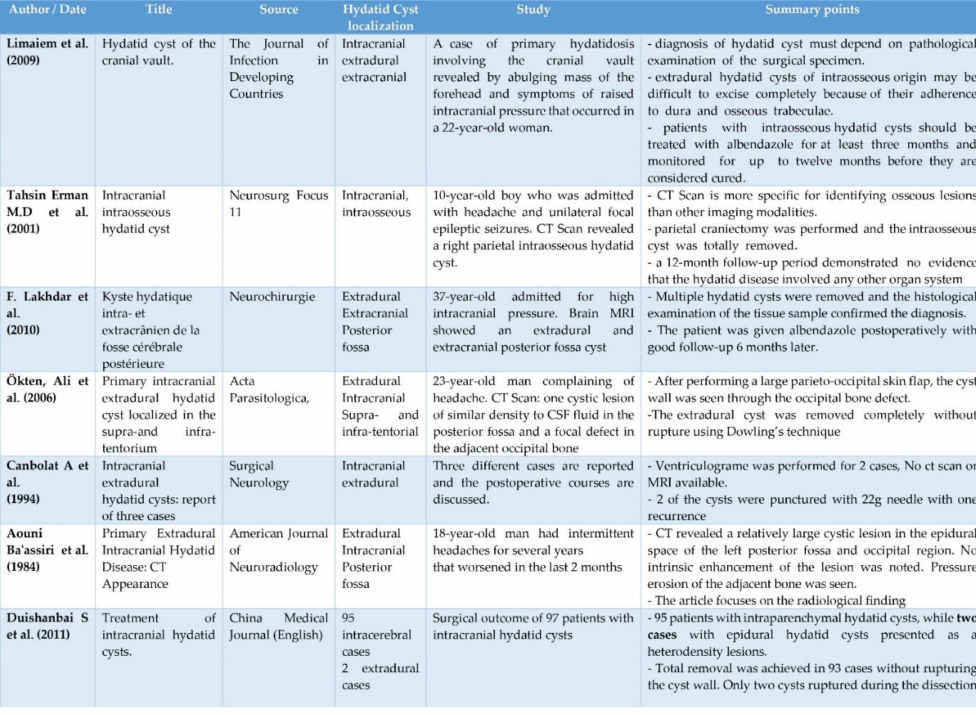
Figure A1. Articles review summary including all reported cases that discuss intracranial-extradural hydatid cysts.